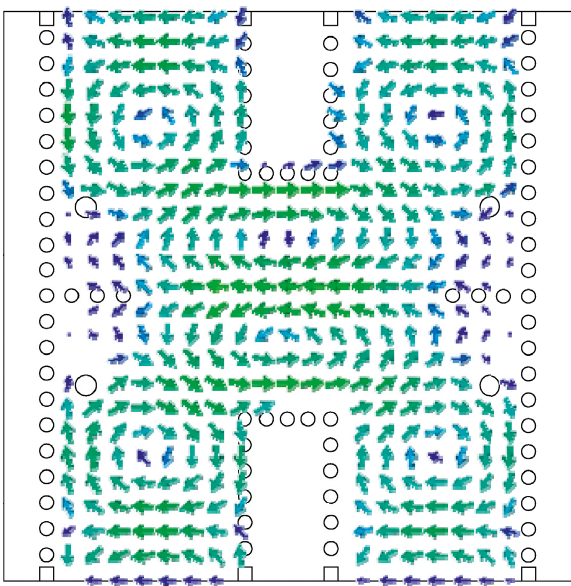
Figure 11: Simulated magnetic field distribution in the feeding network of 2 × 2 subarray at 15GHz.